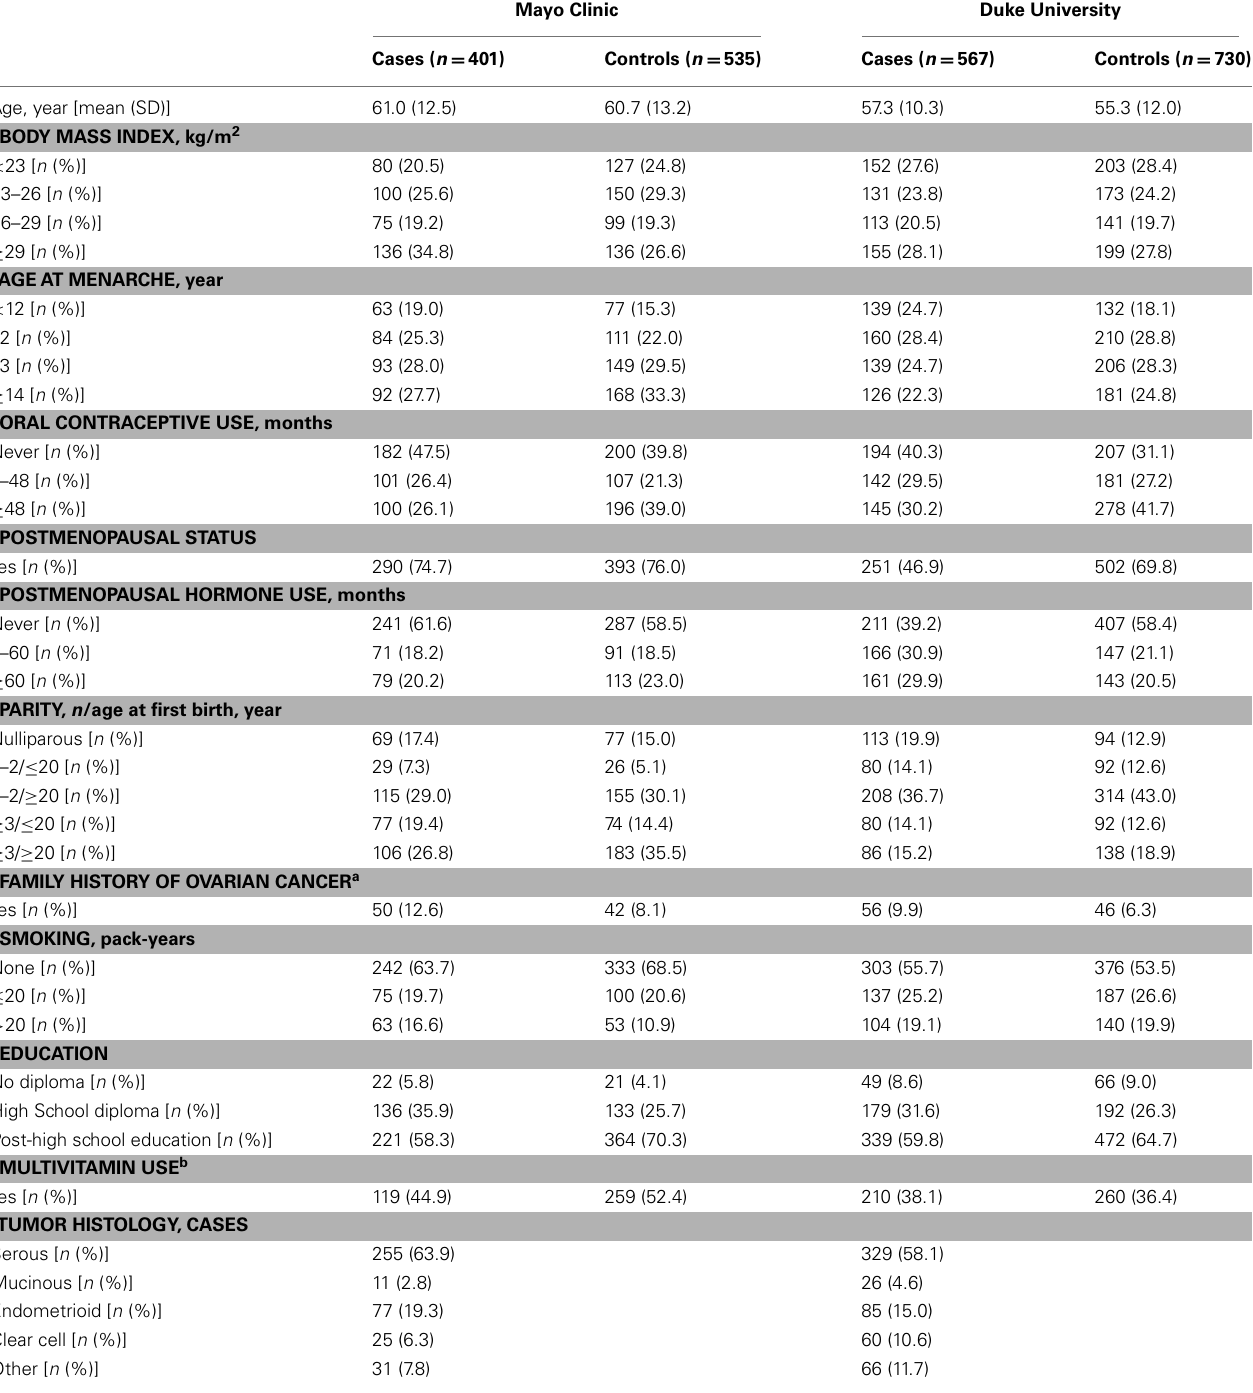
Table 1 | Characteristics of 2,233 Caucasian subjects (Phases 1 and 2), Mayo Clinic, and Duke